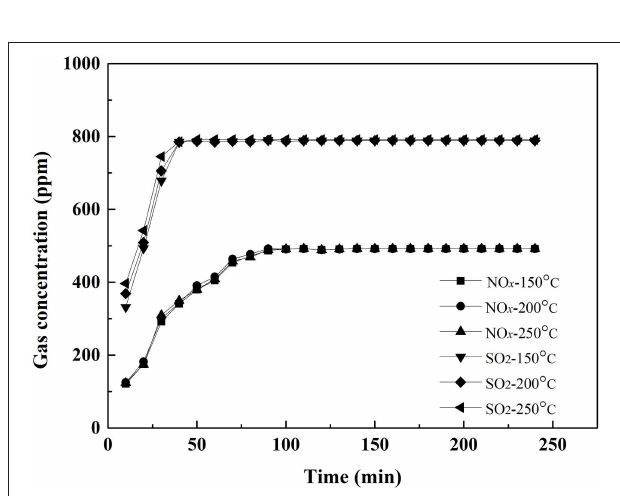
FIGURE 5 | Denitration efficiency of catalysts after SO 2